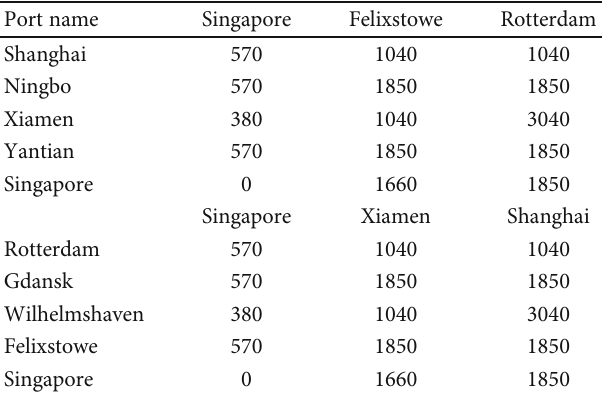
Table 4: Original chromosome 1.